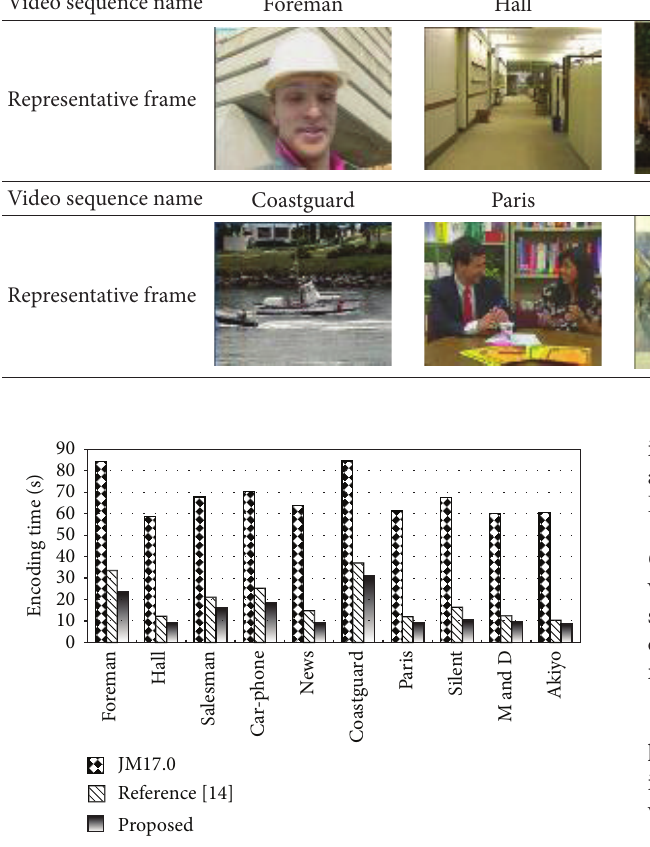
Figure 6: Comparison of the computational complexity